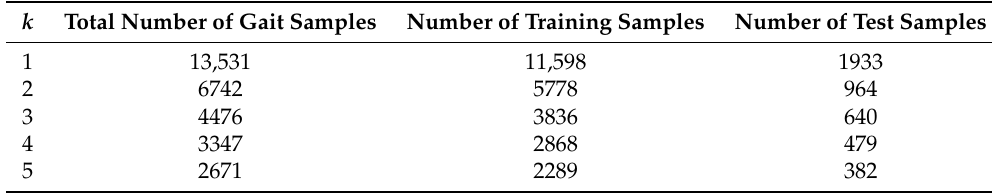
Figure 10. Classification rates of multi-modal DCNNs for various k . ( a ) randomly selected 1000 training data samples and 1000 test data samples; ( b ) 7-fold cross validation. Table 2. The total number of gait data samples according to the value of k and the number of training and test samples in each iteration of 7-fold cross